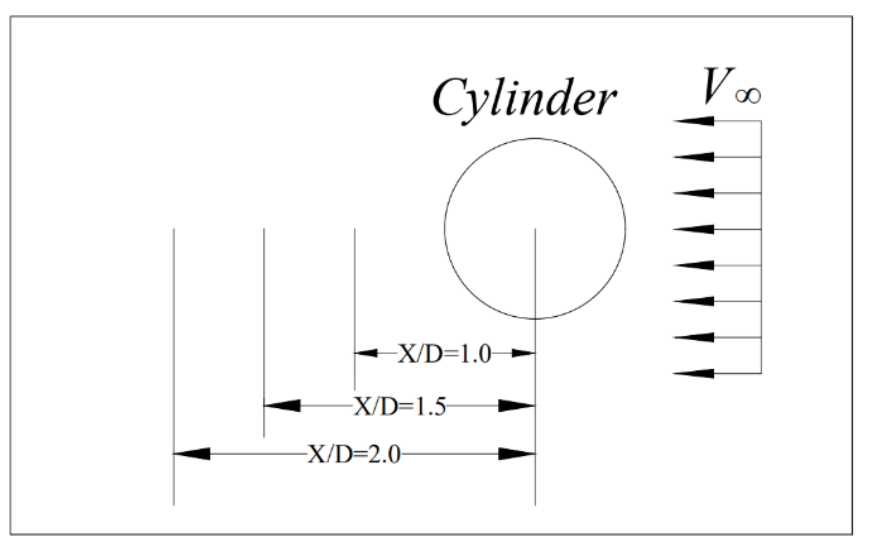
Figure 9. Position diagram for velocity distribution.